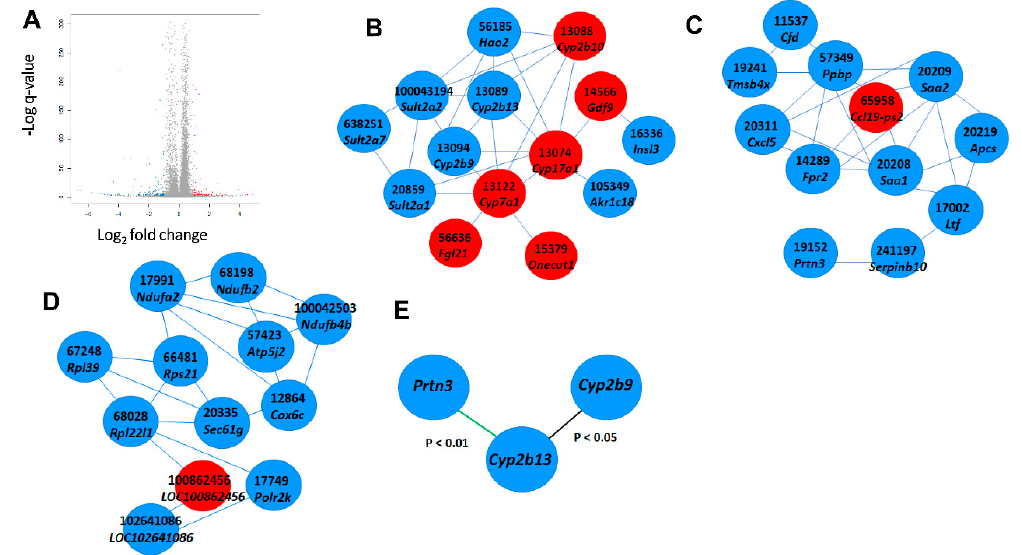
Figure 4. Significant expression changes and major networks involved. ( A ), Volcano plot representing control vs. erythrodiol differentially expressed genes; 68 up regulated genes and 124 down-regulated with false discovery rate q < 0.001; 16.375 no change with 2 fold change. ( B ), network of genes involved in detoxification, ( C ), network of genes involved in protein metabolism and ( D ), network associated with DNA. Red color denotes up-regulation while blue corresponds to down-regulation. ( E ), significant association of genes expressions assayed with RT-qPCR.